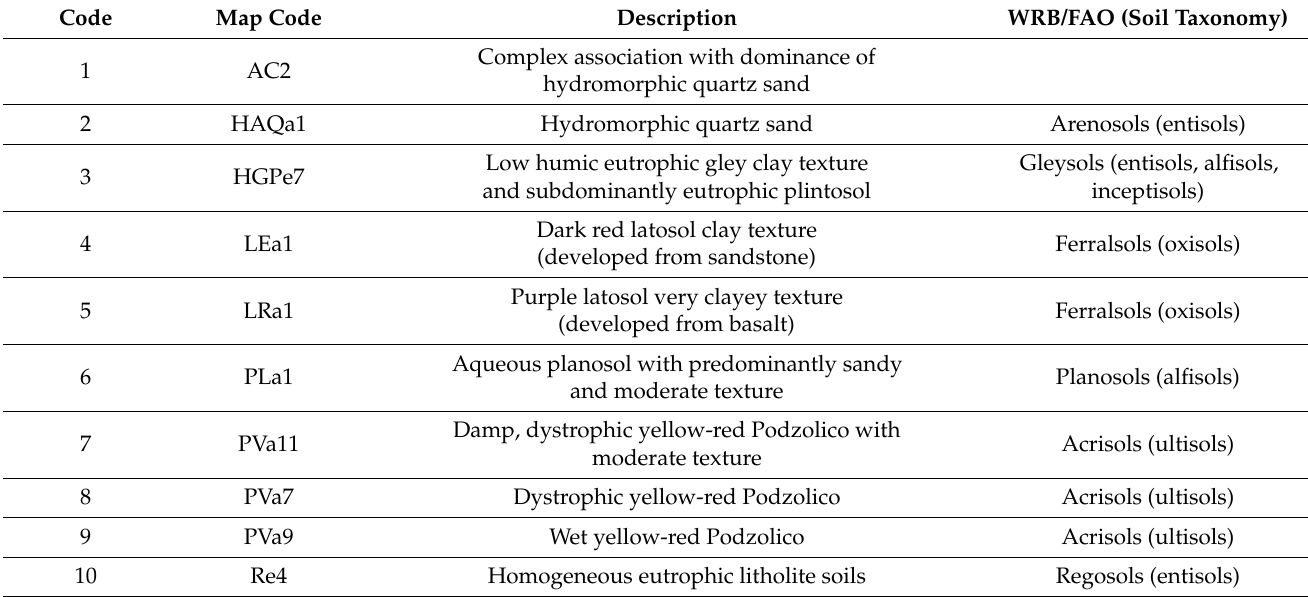
Table 1. Coding for soil type